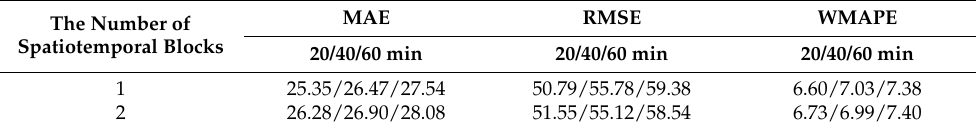
Figure 8. Evaluation metrics for 20 min TI obtained by GCTN with various model configurations. ( a ) Attention heads; ( b ) Feature channels; ( c ) Chebyshev orders. Table 2. Evaluation metrics for 20 min TIs obtained by GCTN with spatiotemporal block.